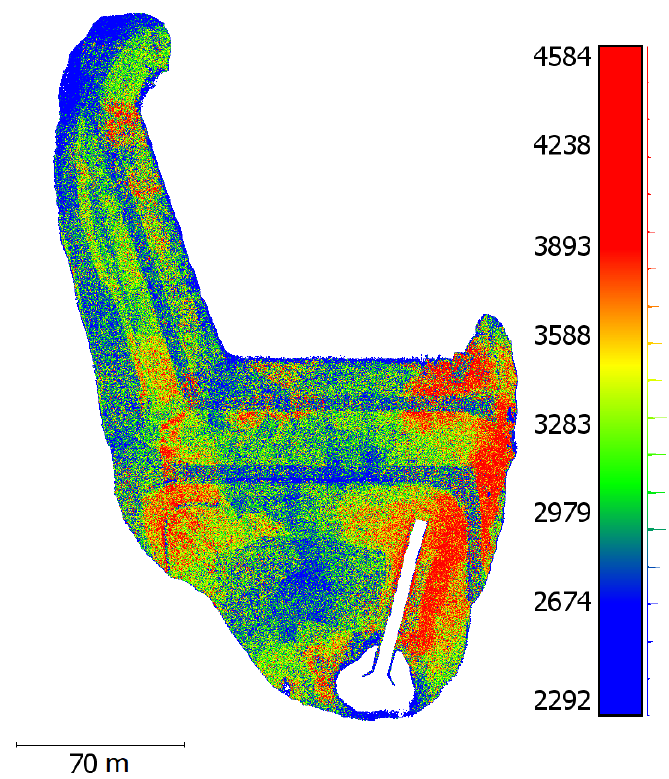
Figure 10. A map of the resolutions calculated as the number of surface points within a 1 cm radius.